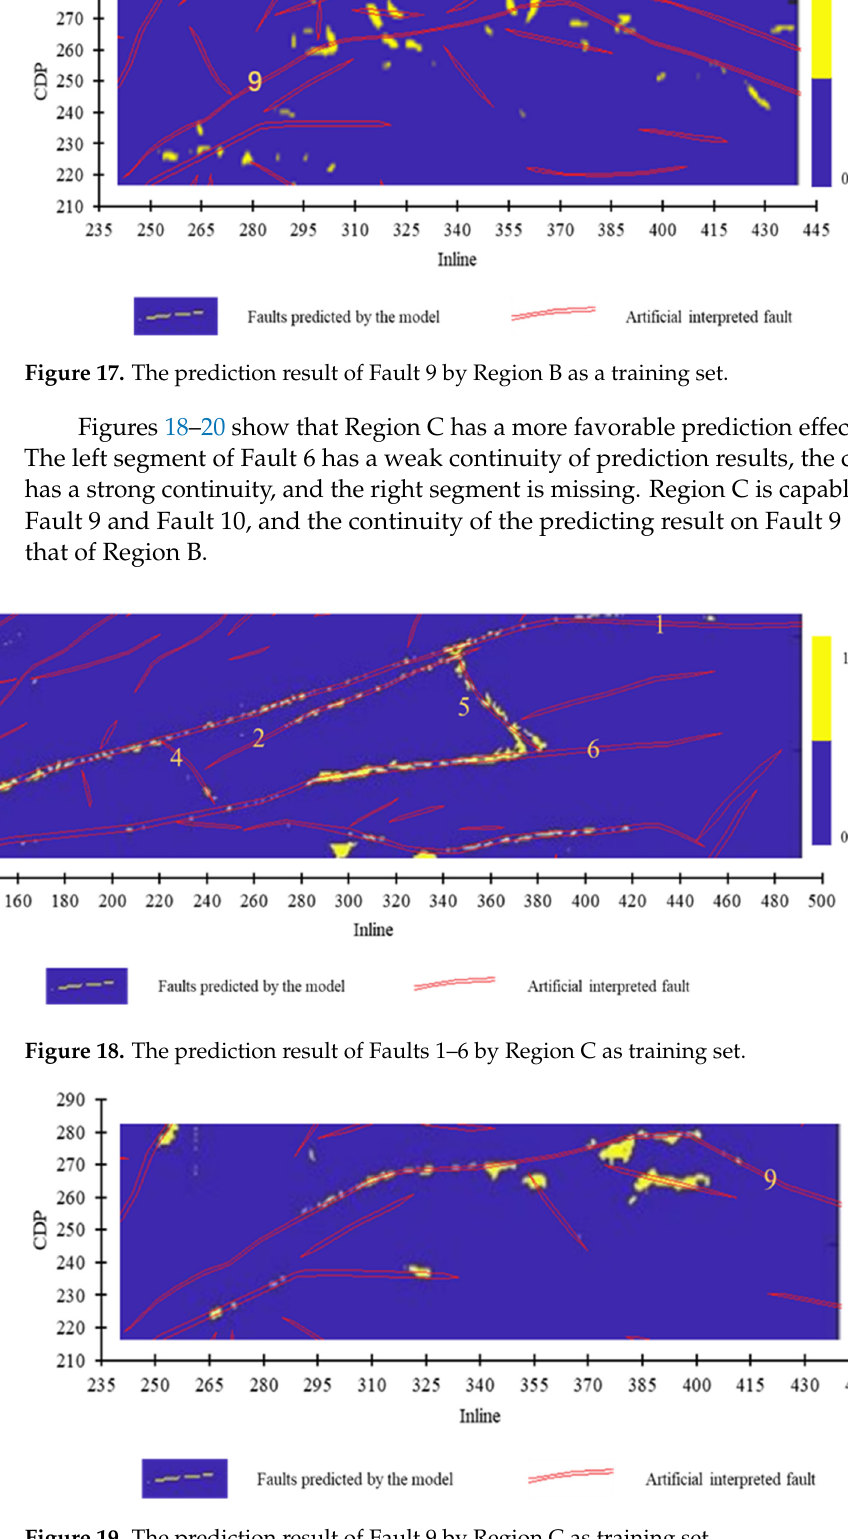
Figure 16. The prediction result of Faults 9–10 by Region A as a training set.